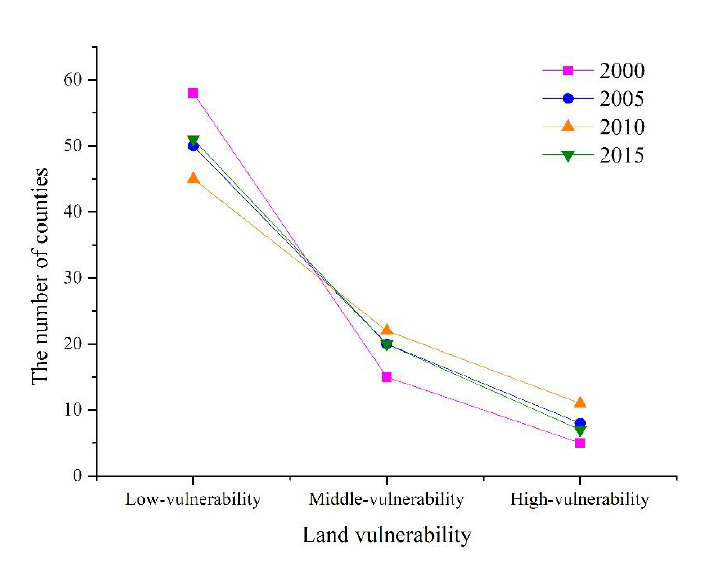
Figure 4. The number of counties with different LVI.